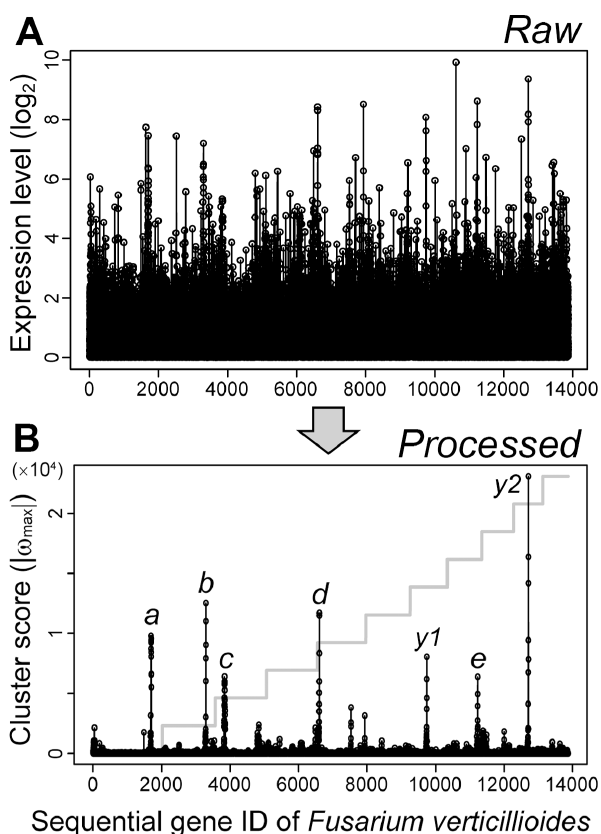
Figure 3. Clear detection of known SMB gene clusters in F. verticillioides by MIDDAS-M. (A) Expression levels of each gene on the F. verticillioides genome in 4 samples of a transcriptome time series at 24, 48, 72, 96 h in liquid fumonisin-inducing media. The highest value of the 4 expression levels was plotted for each gene. (B) Absolute maximum cluster scores (| v max |) by the comprehensive pair-wise calculation ( 4 C 2 ) for each gene detected from the same transcriptome data as A. The step line plot in gray denotes the individual chromosomes. The peaks designated by a through e correspond to the 5 experimentally validated SMB clusters: a , fumonisin; b , perithe- cium pigment; c , fusaric acid; d , bikaverin; e , fusarin. Two peaks to which any known gene clusters do not correspond were designated as y1 and y2 .